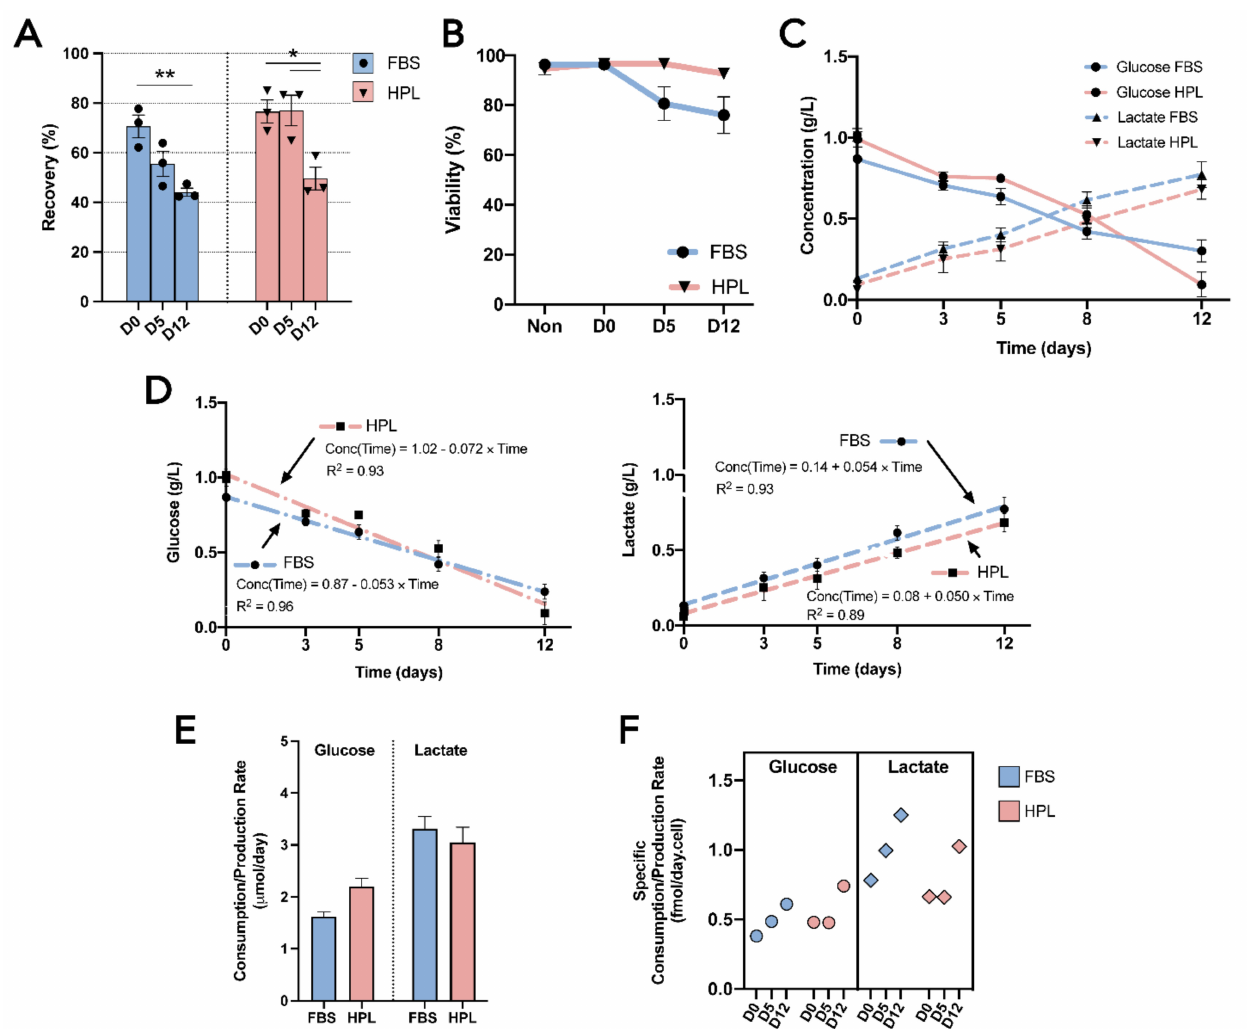
Figure 2. Cell encapsulation performance and MSC(AT) metabolic analysis. ( A ) Cell recovery from alginate beads after 30 min (D0), 5 days (D5), and 12 days (D12) for MSC-FBS (blue) and MSC- HPL (red). ( B ) Cell viability of MSC(AT) before encapsulation (Non) and after their release from encapsulation at D0, D5, and D12. ( C ) Glucose and lactate concentration profiles. ( D ) Glucose ( left ) and lactate ( right ) profile regression modelling, including the fitting of first-order regressions with the presentation of the equation and coefficient of determination (R 2 ). ( E ) Molar glucose consumption and lactate production rates. ( F ) Specific molar glucose consumption and lactate production rates at the various encapsulation timepoints. (Three MSC(AT) donors; mean ± SEM; * p < 0.05, ** p <